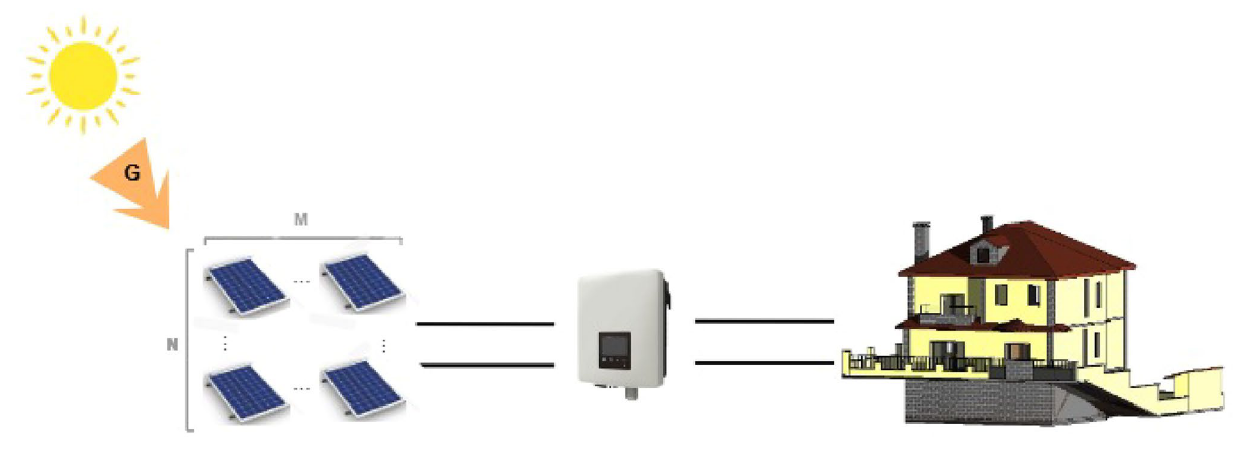
Fig. 1 Photovoltaic system